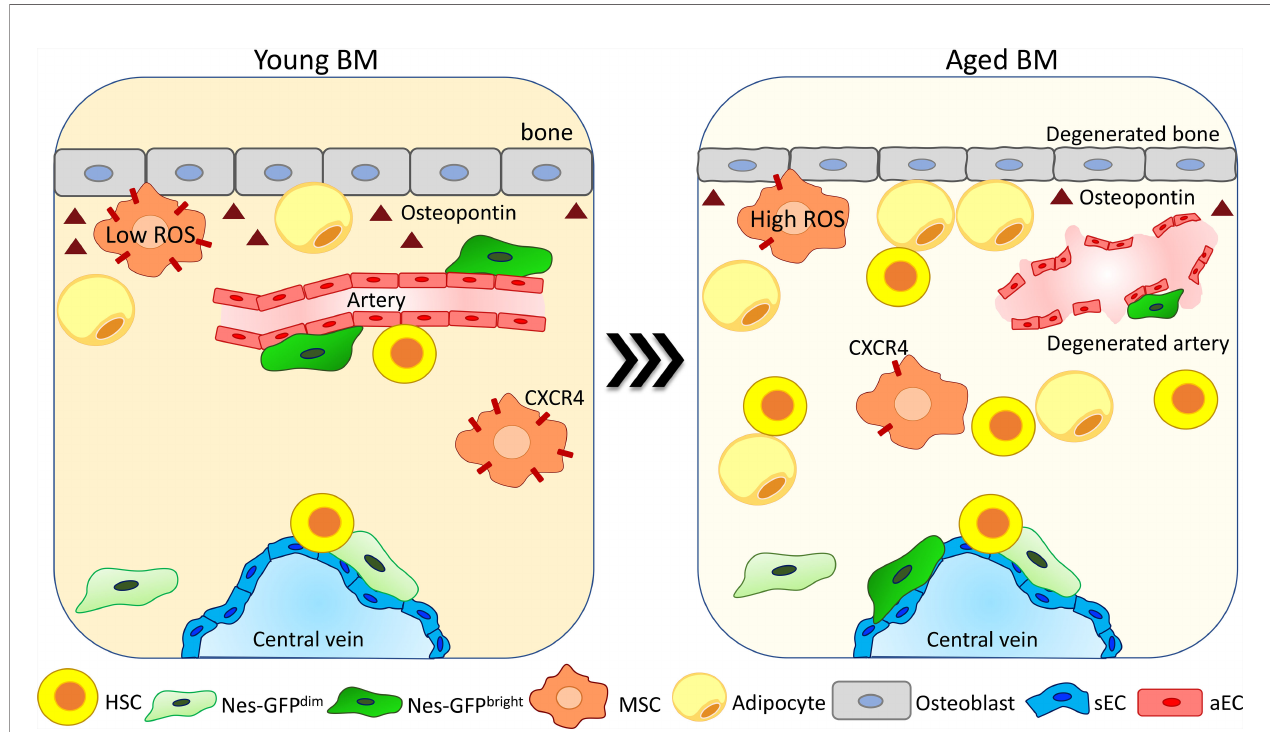
FIGURE 2 | Degeneration and reorganization of the endosteal niche upon aging. The endosteal niche is one of the most affected compartments upon aging. The bone area is compromised due to a reduction in the number of osteoblasts and in osteopontin (OPN) release (26, 66, 81). Arteries and arterioles degenerate, becoming no more able to support HSC function (40, 41, 75). NES bright cells change their localization from arteries moving in proximity to sinusoids, while NES dim cells do not change their localization (40, 75). The MSC population is increased upon aging (81). MSCs reduce CXCR4 expression and increase ROS production, reducing their colony-forming ability and becoming less supportive for HSC maintenance (82). Adipocytes increase in number due to an enhanced pro-adipogenic differentiation of MSCs (83), promoting HSC myeloid differentiation skewing